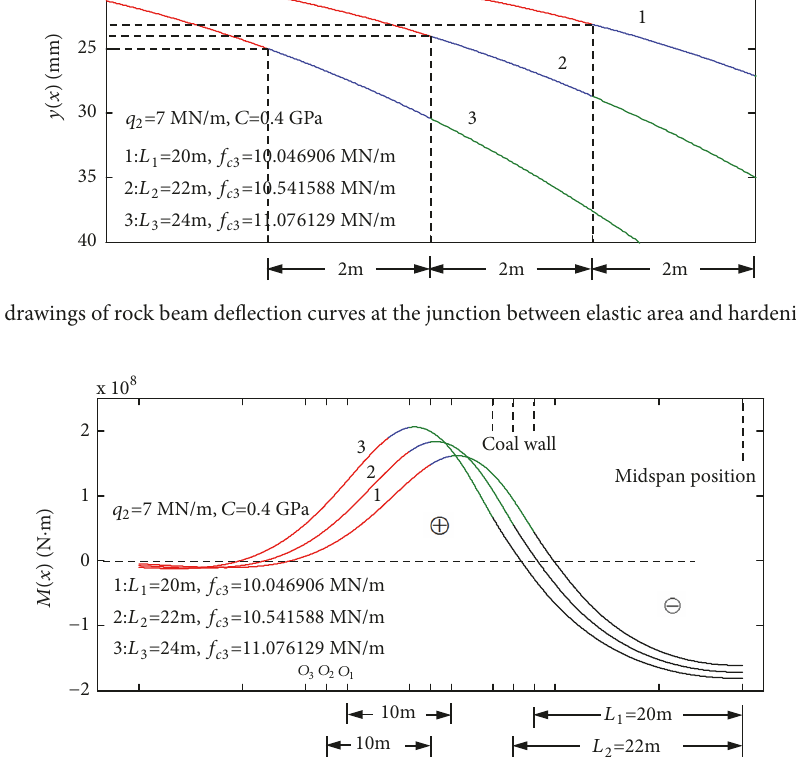
m and curves 1, 2, and 3 are 23.10, 24.01 and 25.00 mm.